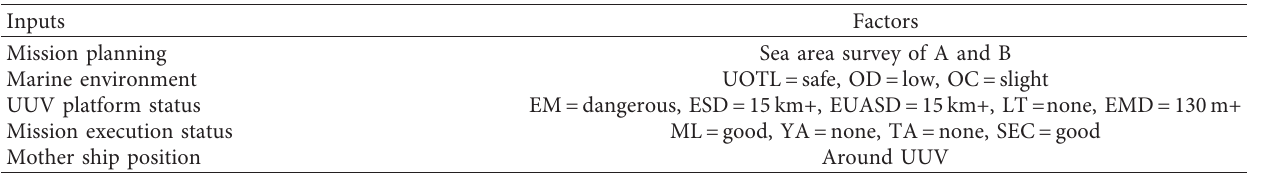
Table 9: Simulation input conditions.